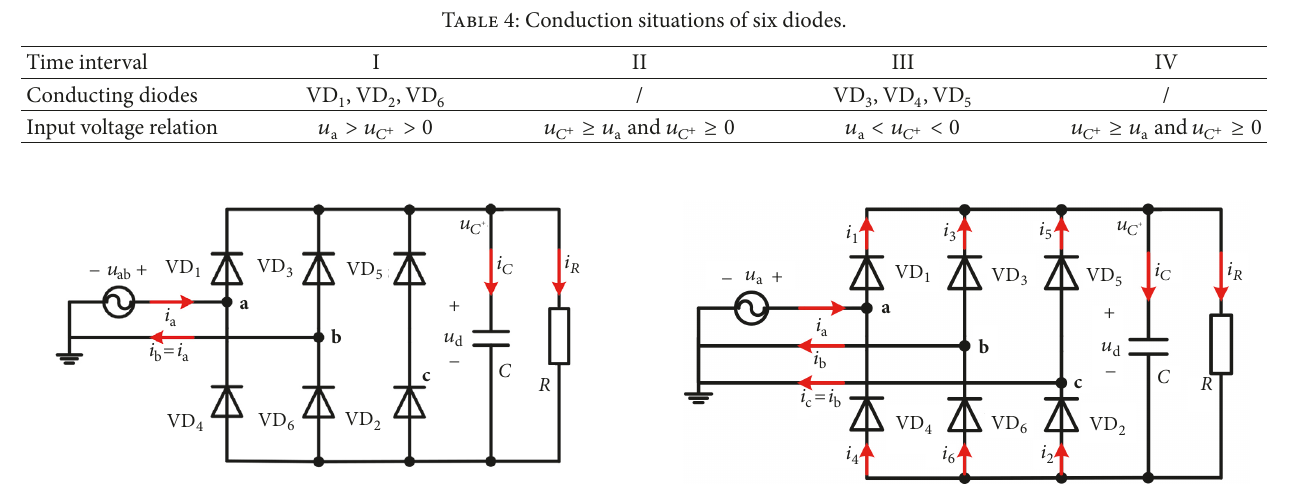
Figure 11: Three-phase bridge rectifier circuit running under two- phase short-circuit